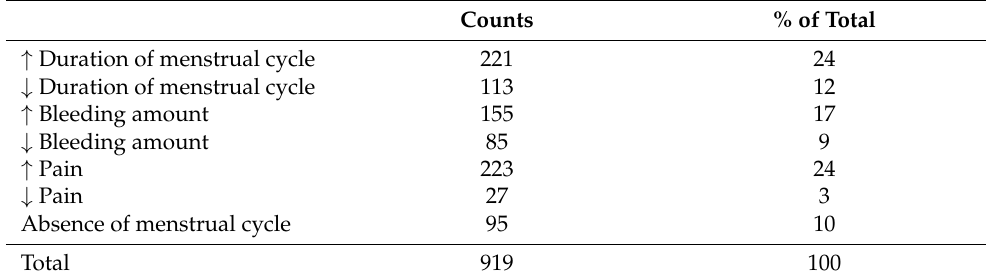
Table 2. Alterations regarding menstrual cycle reported after COVID vaccination.